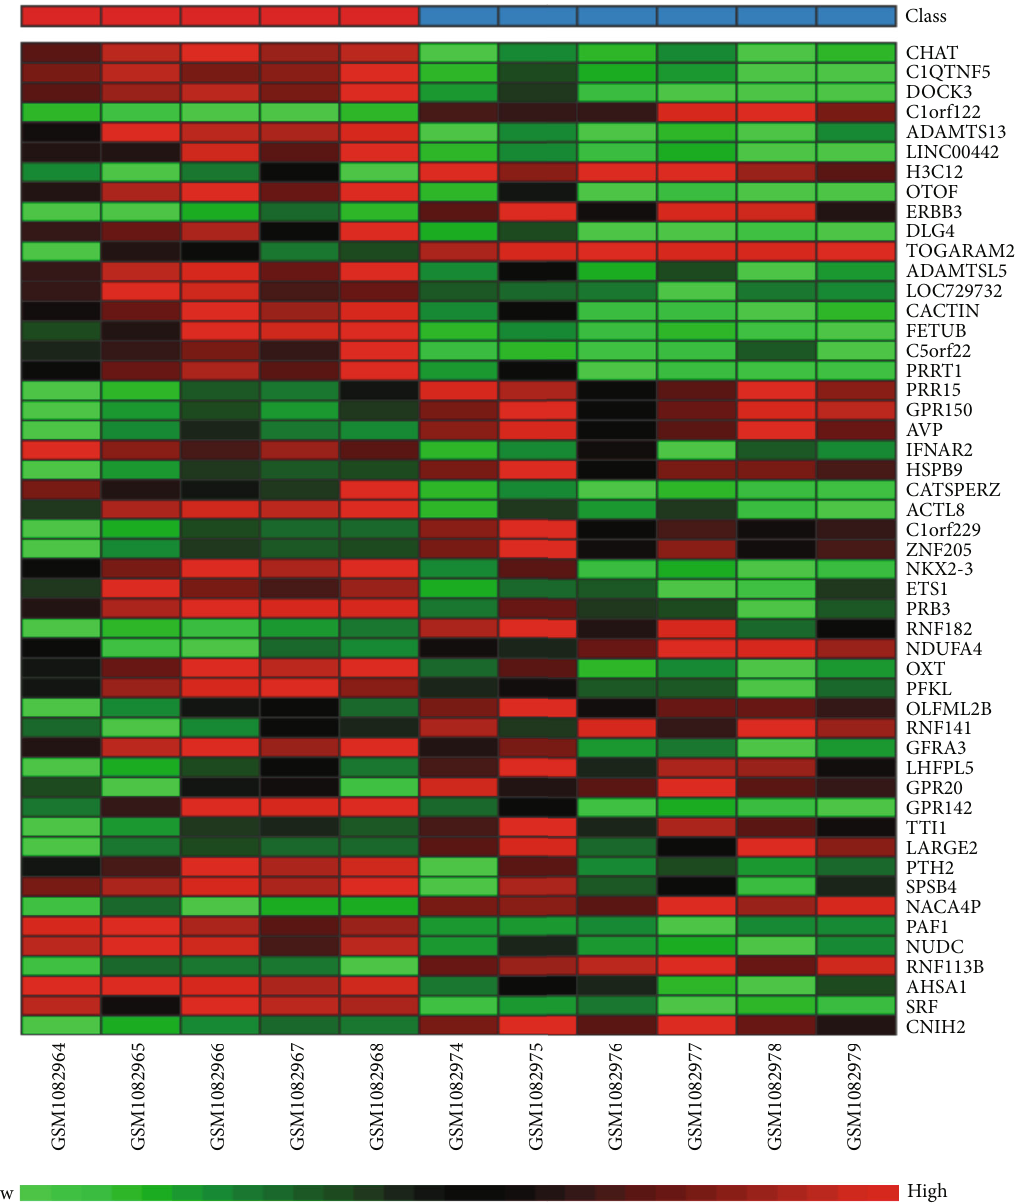
Figure 2: Heat map of di ff erentially expressed genes. The abscissa represents di ff erent samples, and the ordinate represents di ff erent genes. The red boxes indicate upregulated genes, and the green boxes indicate downregulated